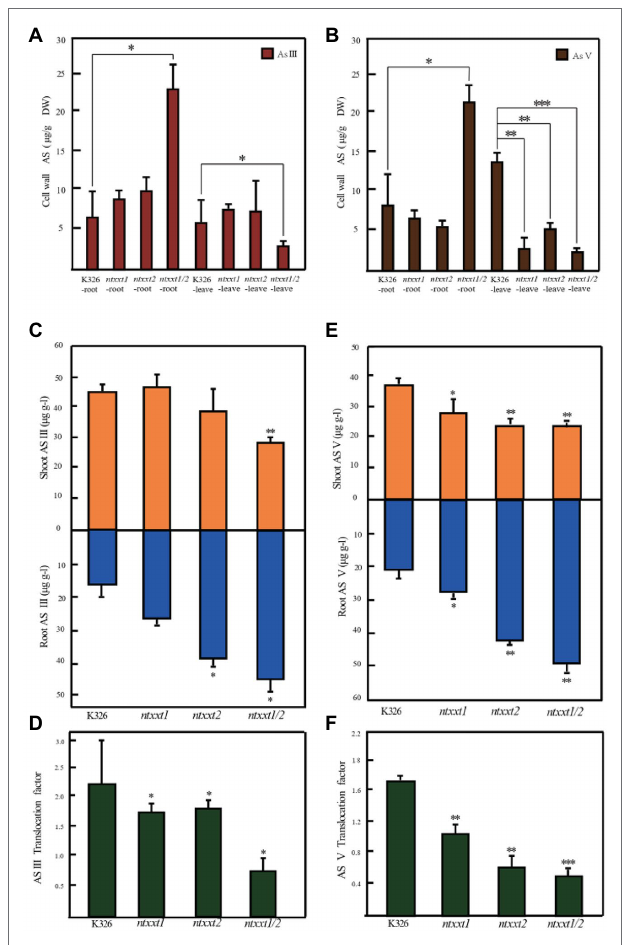
FIGURE 7 | The As accumulation and translocation in ntxxt1/2 double mutants grown with AsIII or AsV. (A) The amounts of As in the leaf and roots cell walls of K326, ntxxt1 , ntxxt2 , and ntxxt1/2 grown with AsIII. (B) The amounts of As in the leaf and root cell walls of K326, ntxxt1 , ntxxt2 , and ntxxt1/2 grown with AsV. (C,E) The amounts of As in shoots and roots of K326, ntxxt1 , ntxxt2 , and ntxxt1/2 grown in the presence of AsIII or AsV. (D,F) Translocation factor (As concentration ratio in shoots to roots) for K326, ntxxt1 , ntxxt2 , and ntxxt1/2 grown in the presence of AsIII or AsV. Experiments were performed in three biological replicates, and each biological replicates were performed in three technological replicates. Error bars, mean ± SE. * Statistically significant differences from K326 using Student’s t -test ( p < 0.05), ** statistically significant differences from K326 using Student’s t -test ( p < 0.01), *** statistically significant differences from K326 using Student’s t -test ( p <